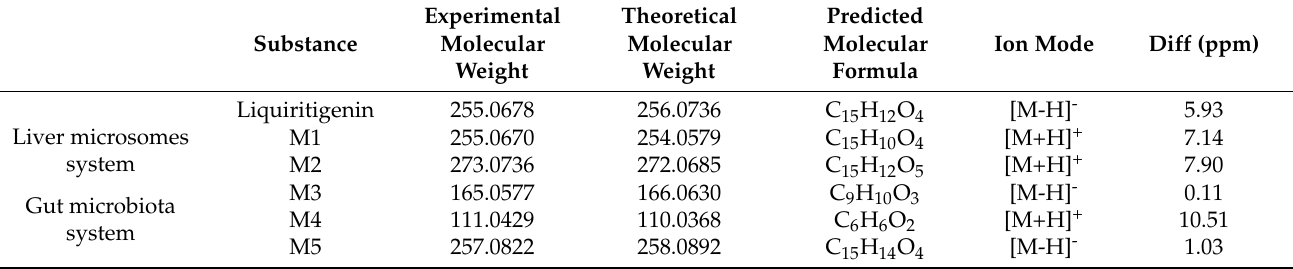
Table 2. The accurate mass measurements of molecular and fragment ions of liquiritigenin and its metabolites in the intestinal microflora metabolic system and liver microparticle incubation